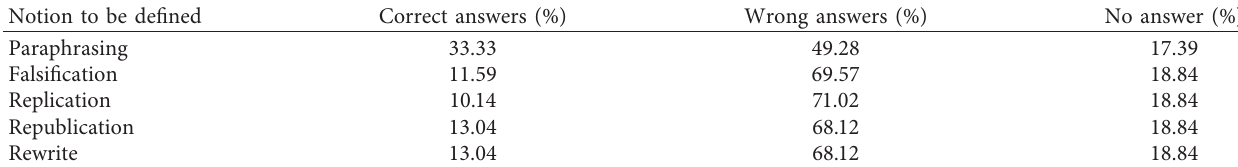
Table 4: Students’ understanding of the categorical framework of intellectual property.